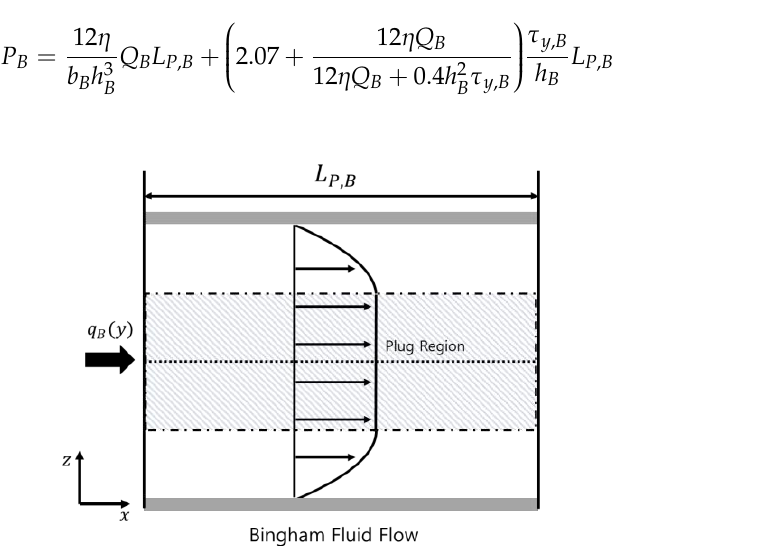
Figure 12. Mean velocity profile of MR fluid in the bypass orifice.